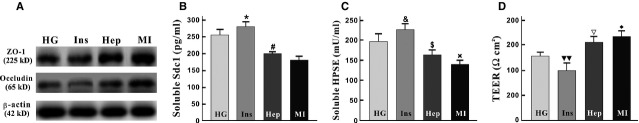
Treatments regulates Sdc1/HPSE expression and barrier function in high-glucose condition. IEC-6 cells were conventionally grown and processed with high glucose alone (HG group), or high glucose with insulin (Ins group), or high glucose with heparin (Hep group), or high glucose with SB203580 (MI group) as mentioned in ‘Materials and methods’. (A) The comparison of Occludin (P = 0.016) and ZO-1 (P = 0.025) in groups was significant. (B and C) Instead of insulin, heparin and SB203580 help alleviate the cleavage of Sdc1 (*/#F = 51.3, P = 1.4 × 10−5) and inhibit the elevation of HPSE (&/$/xF = 29.2, P = 1.2 × 10−4). (D) TEERs in Hep and MI group were obviously higher than those in HG and Ins group (▾▾/▵/♦F = 23.2, P = 2.7 × 10−4).